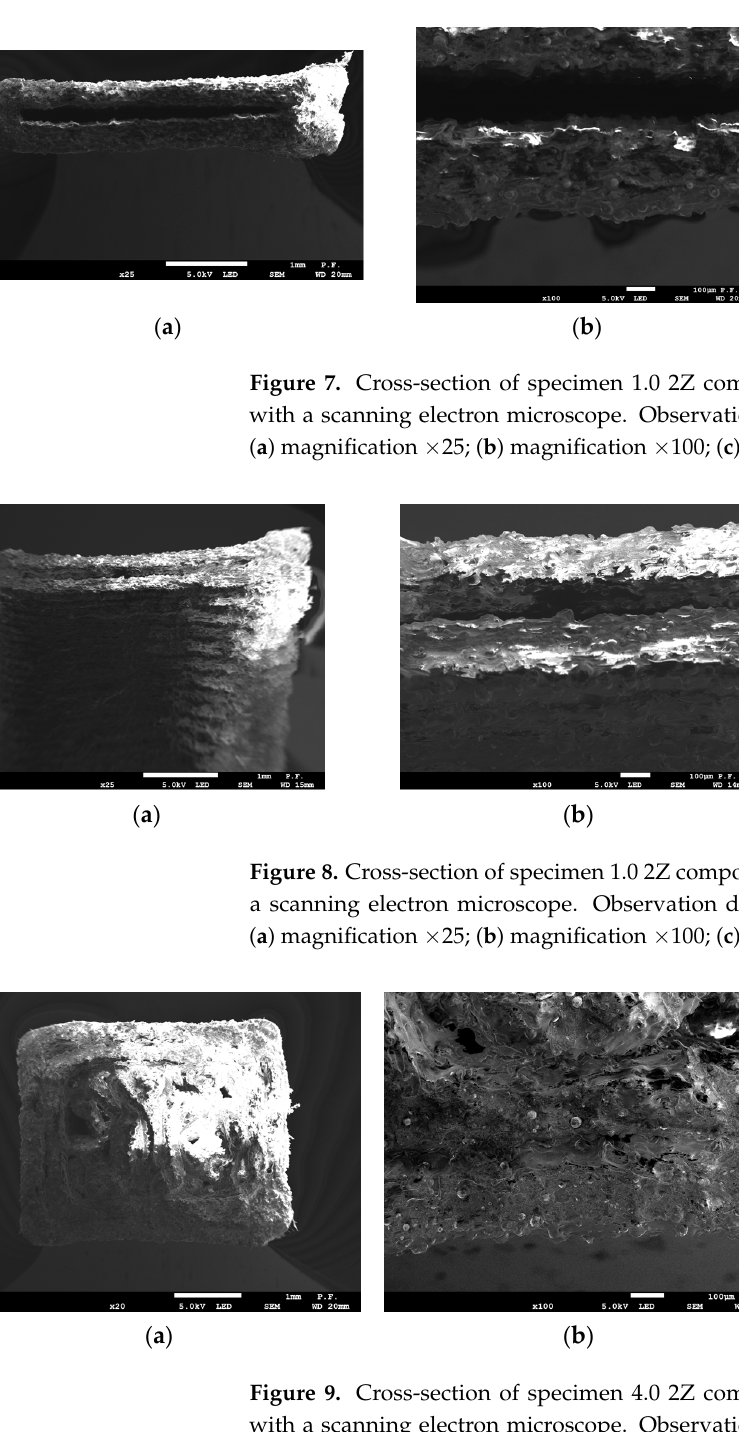
Figure 10. Cross-section of specimen 4.0 2Y composed of PLA + bronze after fracture observed with a scanning electron microscope; ( a ) observation direction—perpendicular to the cross-section; mag- nification ×25; ( b ) observation direction—at an angle of 45° to the cross-section; magnification ×25; ( c ) observation direction—at an angle of 45° to the cross-section; magnification ×100.